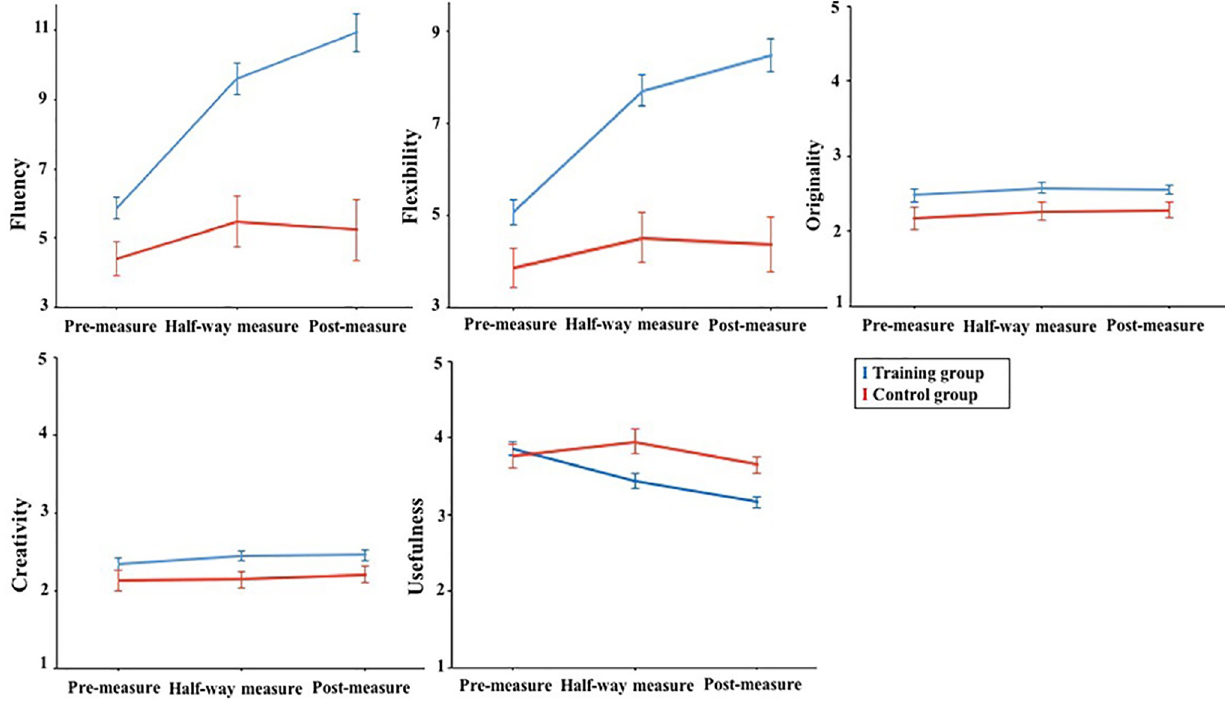
Fig 1. Effects of the creativity training on AUT as function of treatment and measurement